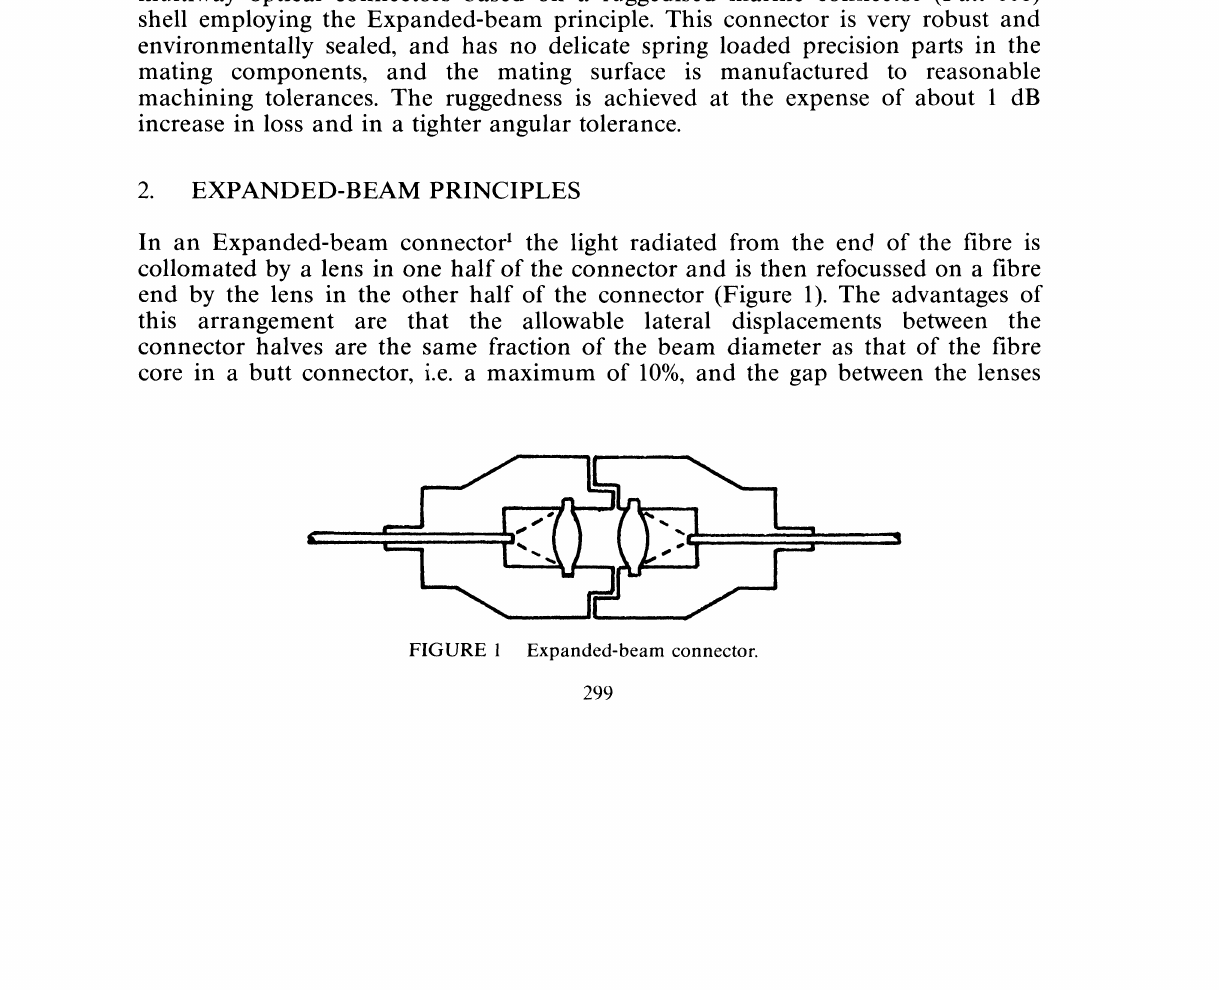
FIGURE Expanded-beam connector.